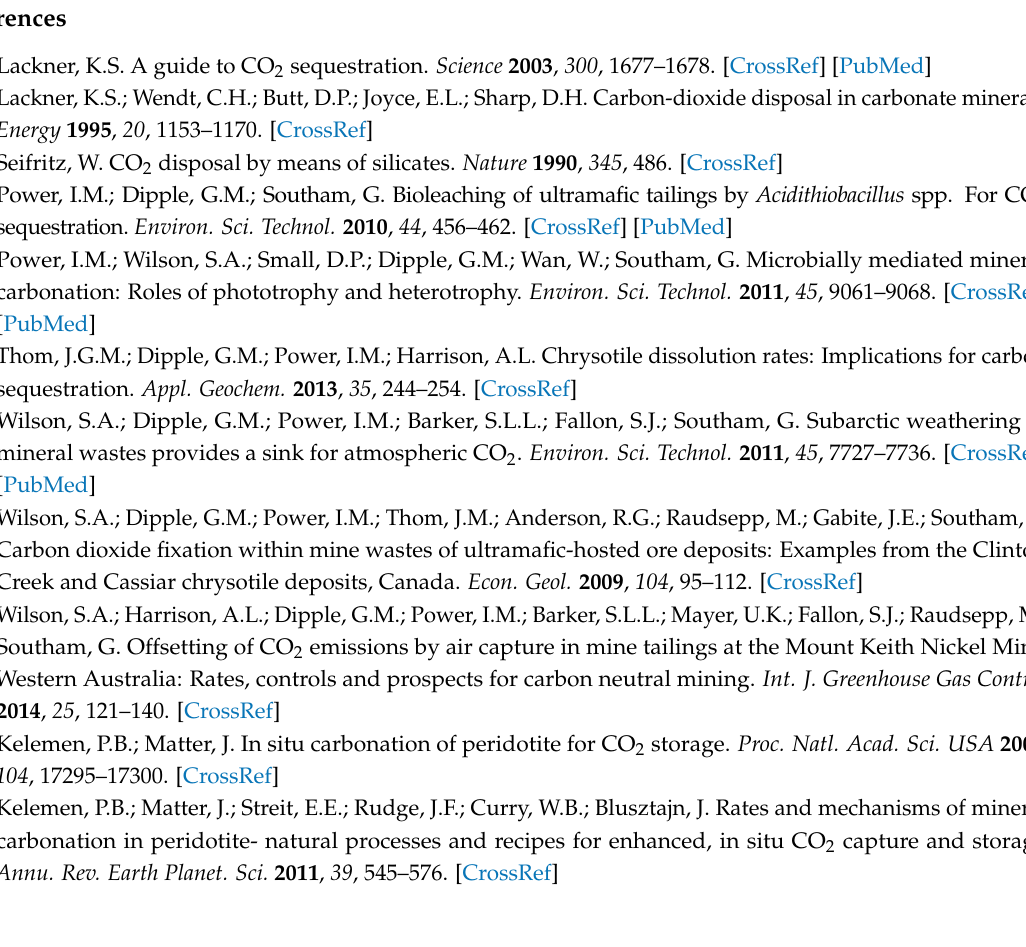
Figure S1: Maximum air temperature ( ◦ C) and precipitation (mm) over the duration of the experiment as measured in a nearby town, Table S1: Cation (ppm) and nutrient concentrations (ppb) in the creek water added to the experimental plots, Table S2: Rietveld results and corresponding R wp values for the control tailings. R wp is the weighted pattern index, a function of the least-squares residual, Table S3: Rietveld results and corresponding R wp values for the tailings sampled after 2 weeks following acid leaching. R wp is the weighted pattern index, a function of the least-squares residual, Table S4: Rietveld results and corresponding R wp values for the tailings sampled after 11 weeks following leaching. R wp is the weighted pattern index, a function of the least-squares